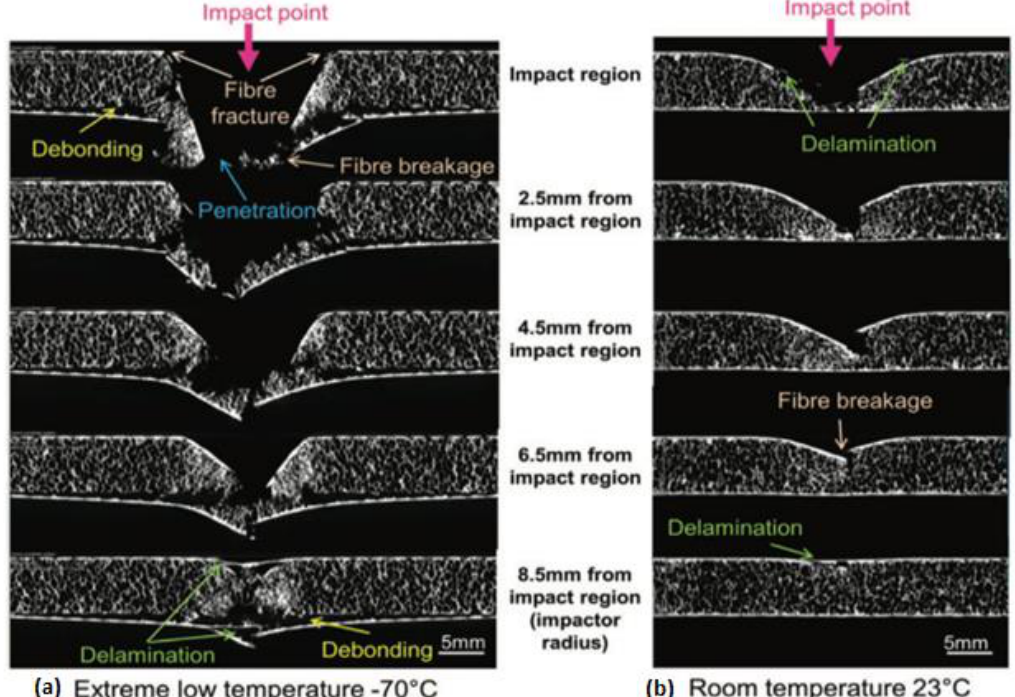
Figure 15. μ CT scans of specimens impacted with 10 J impact energy at ( a ) extreme low temperature − 70 °C and ( b ) room temperature 23 °C [182] (reprinted with permission from SAGE Publications, Licence Number: 5447071365227).